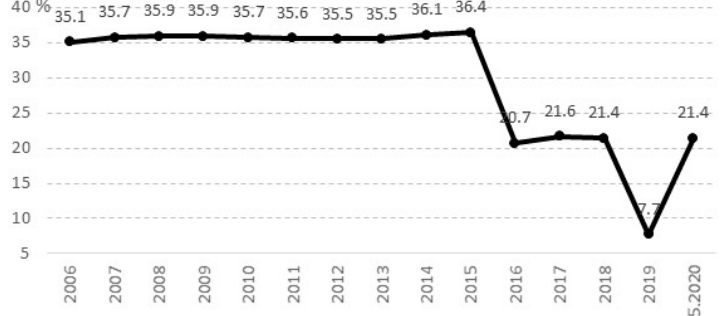
Figure 1. Level of energy poverty in Poland in 2006–May 2020. Source: own calculations based on [58–60].